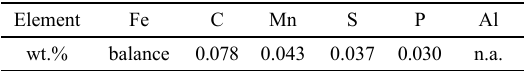
Table 1. Element composition of cold-rolled AISI 1006 steel sheets. Element